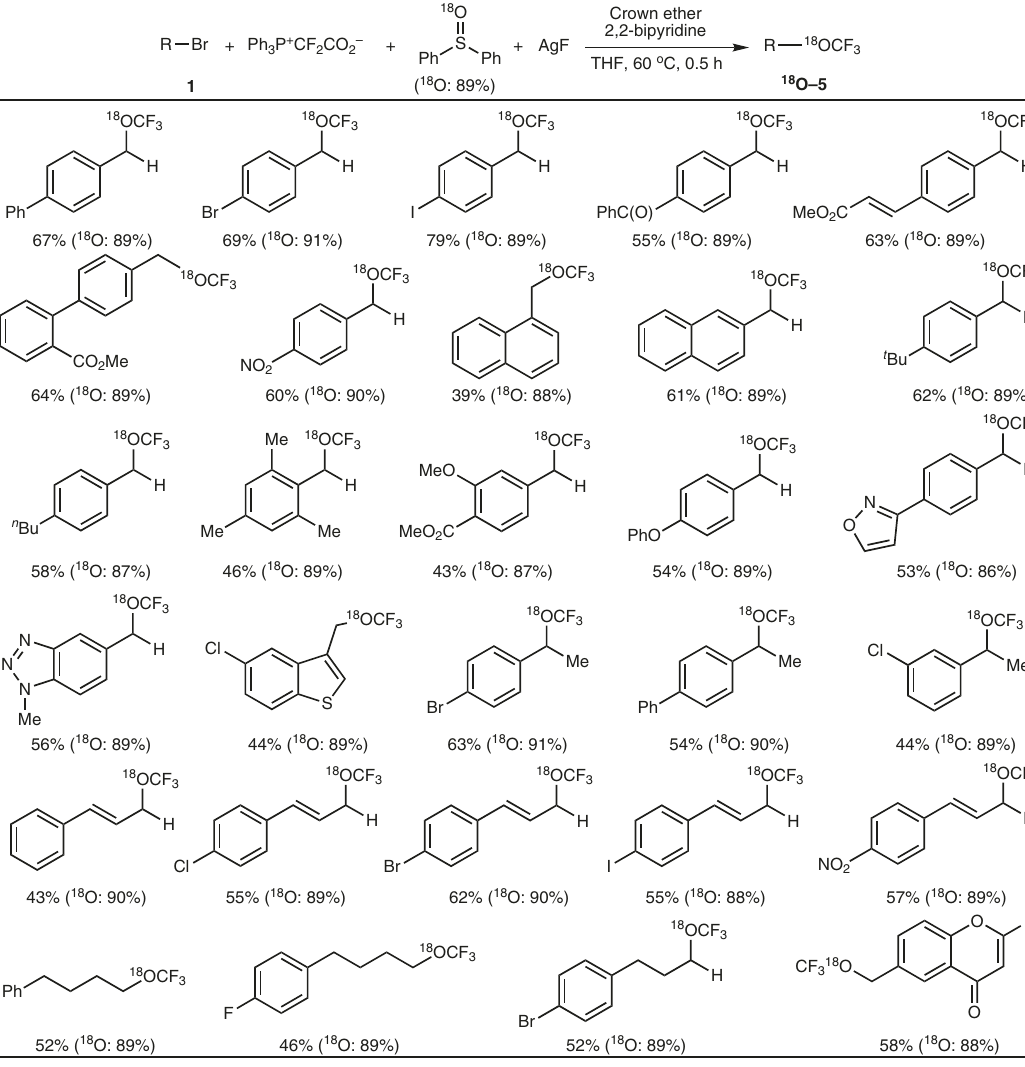
Fig. 6 Di fl uorocarbene-oxidation-based 18 O-tri fl uoromethoxylation. Isolated yields. Reaction conditions: substrate 1 (0.2 mmol), Ph 3 P + CF 2 CO 2 − (2.5 equiv), Ph 2 S = 18 O (2.5 equiv), AgF (2 equiv), 2,2 ′ -bipyridine (1.5 equiv), and 2,3,11,12-dibenzo-18-crown-6 (0.5 equiv) in THF (1.5 mL) at 60 °C for 0.5 h. The 18 O contents were determined by